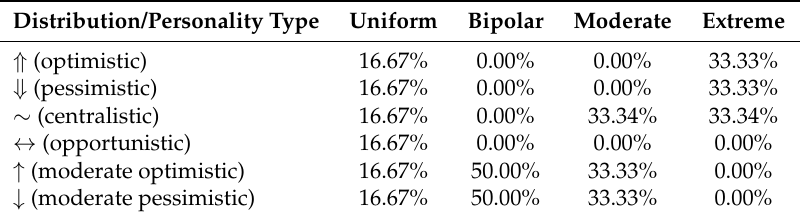
Table 1. Distributions of personality